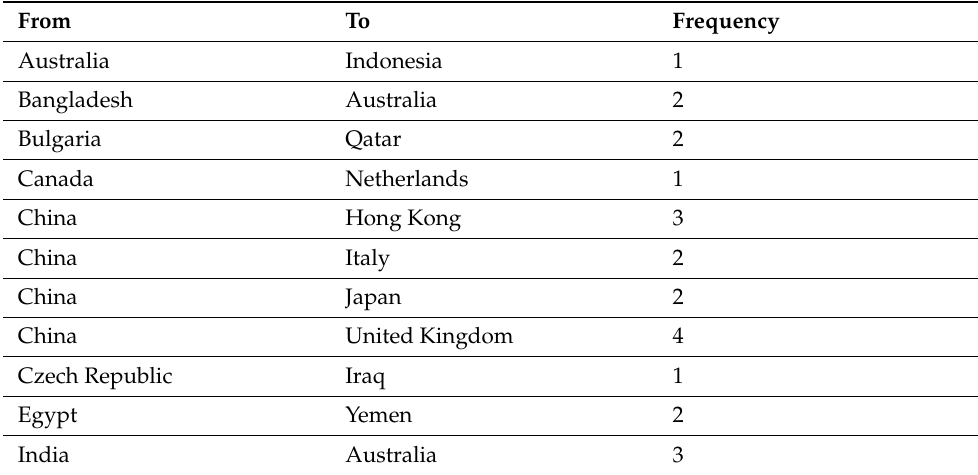
Table 7. Collaboration frequency at the global